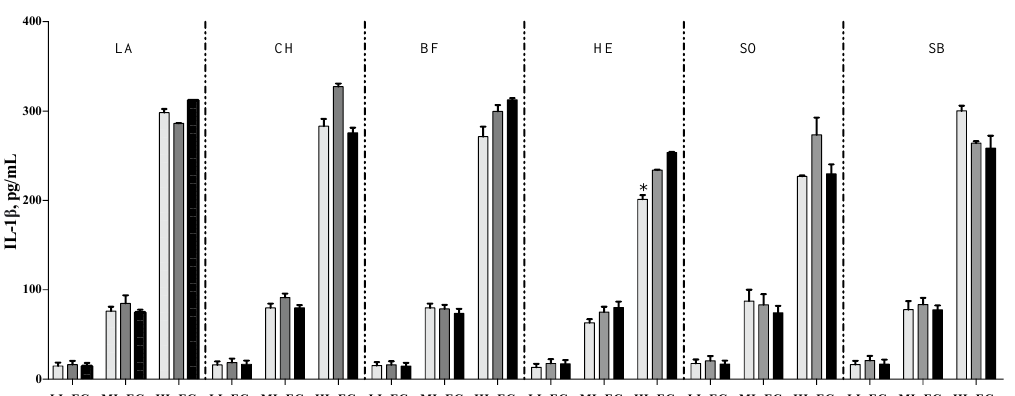
Figure 4. IL-10 secretion (means ± SE; pg/mL) in peripheral blood mononuclear cell supernatants of infants with generalized epilepsy treated in vitro with myofibrillar (MYO, light-grey bar), sarcoplasmic (SA, grey bar), and total protein (TOT, black bar) fractions from beef (BF), lamb (LA), chicken (CH), sole (SO), European hake (EH), and sea bass (SB) sources. LL-EC = group of children with epilepsy with similar levels of cytokines to those of control children; ML-EC = group of children with epilepsy with cytokine levels at least 2-fold higher (medium levels) than those of control children; HL-EC = group of children with epilepsy with cytokine levels at least 8-fold higher (high levels) than those of control children.